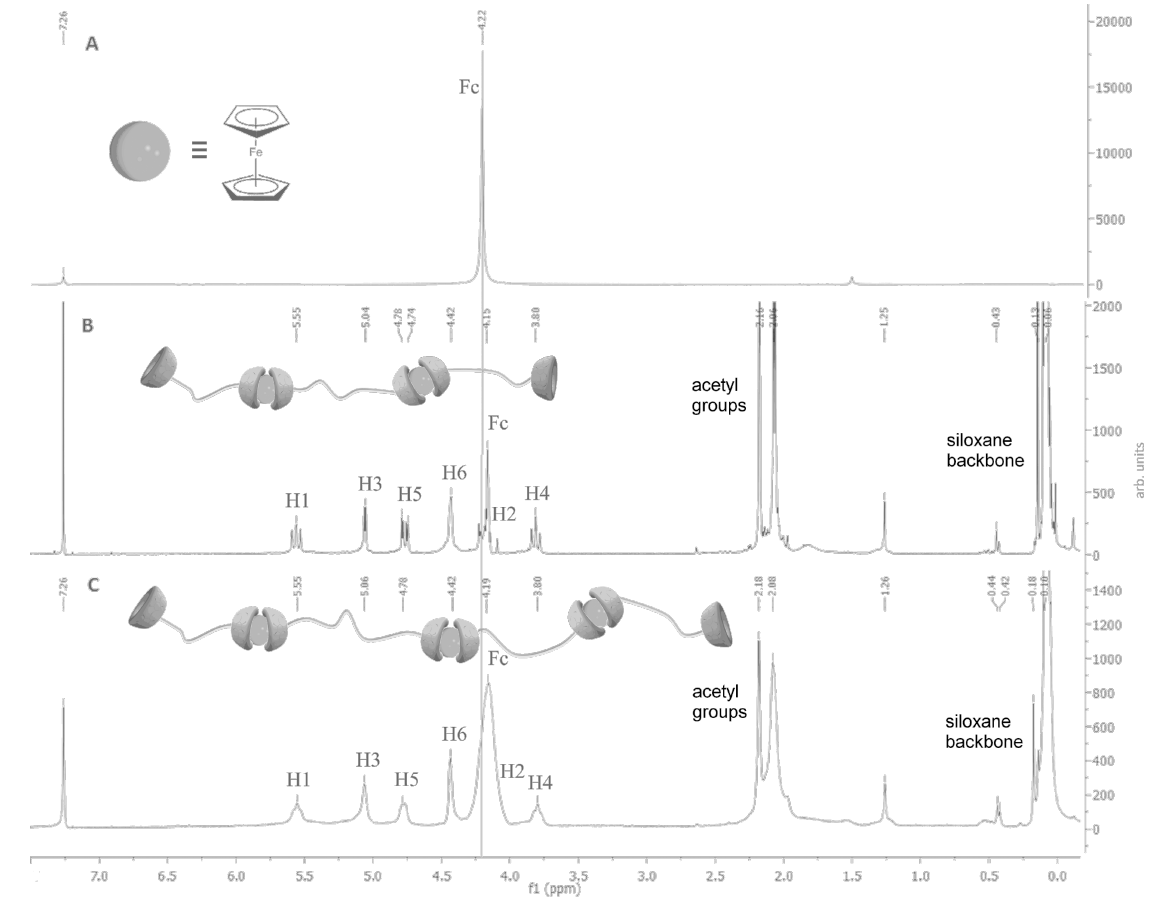
Figure 2: 1 H NMR spectra of ferrocene (A), complex of α -CD-disiloxane ( α -CD-DS) 4 with ferrocene (B) and complex of α -CD-poly(dimethylsiloxane) ( α -CD-PDMS) 5 with ferrocene (C).